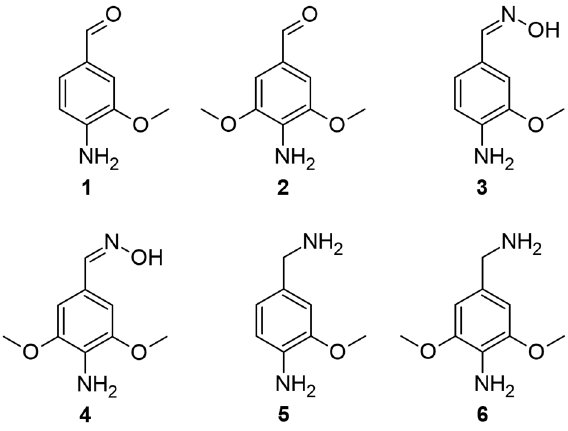
Figure 1. Amines 1 – 6 are synthesized from renewable resources.